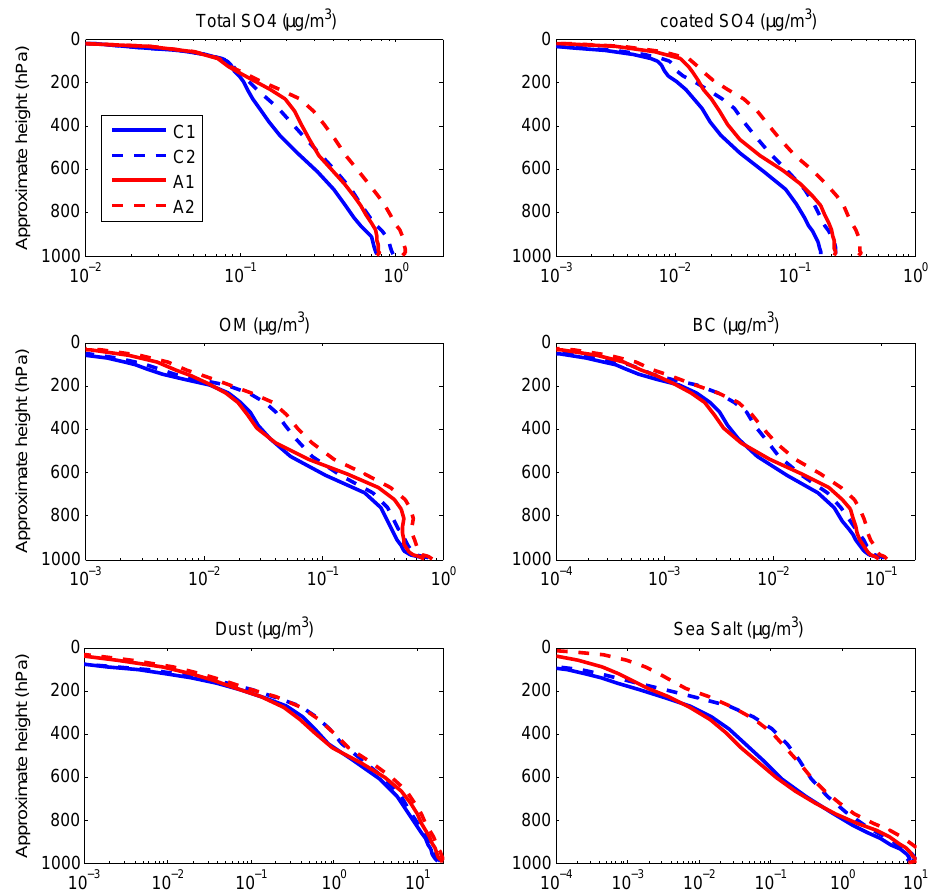
Fig. 8. Annual global mean vertical profiles of sulfate, coated sulfate, OM, BC, dust and sea salt from C1, C2, A1 and